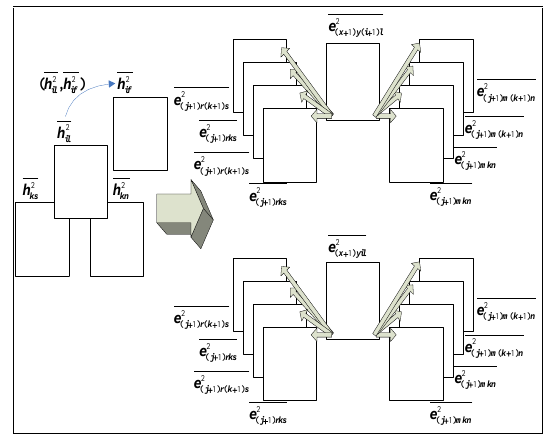
Fig. 6. Mapping of derived structures - the composition of SC schemes determines the composition of NSE schemes (or nesting of